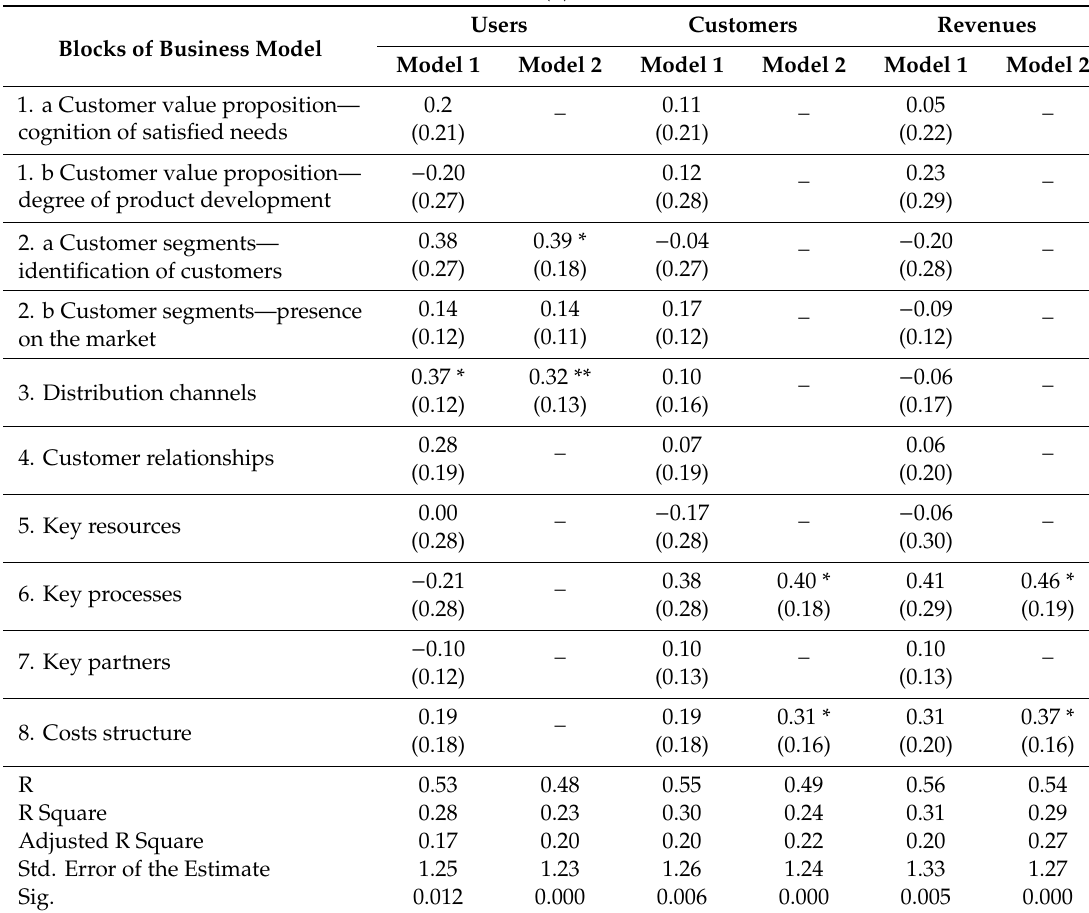
Table 3. ( a ) Relationship between business model and start-up performance. 1st stage of research. ( b ) Relationship between business model and start-up performance. 2nd stage of research. ( c ) Relationship between business model and start-up performance. 3rd stage of